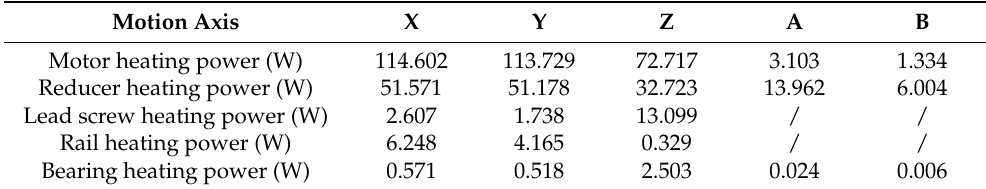
Table 1. Heating power.